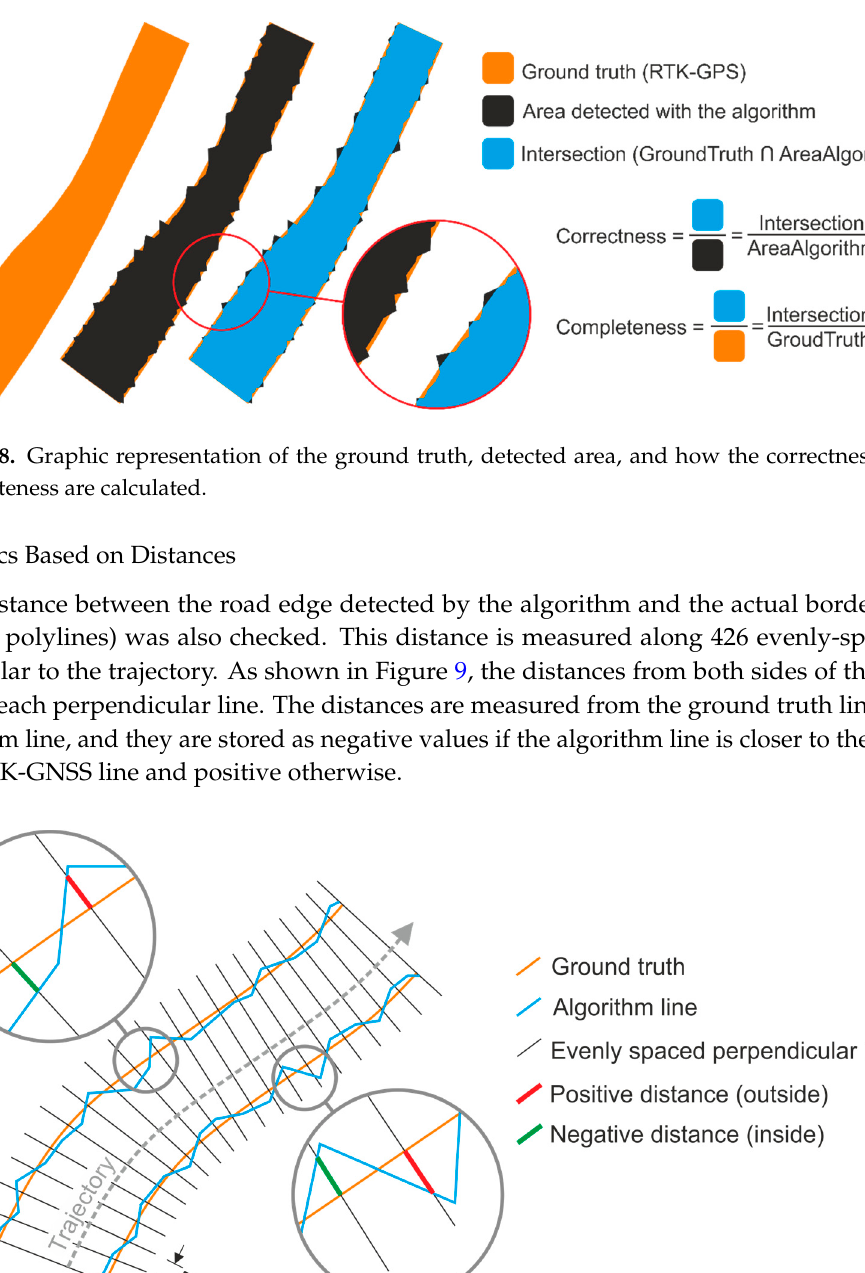
Figure 8. Completeness represents the proportion of the actual road surface that was satisfactorily detected (i.e., the blue area divided by orange area in Figure 8).